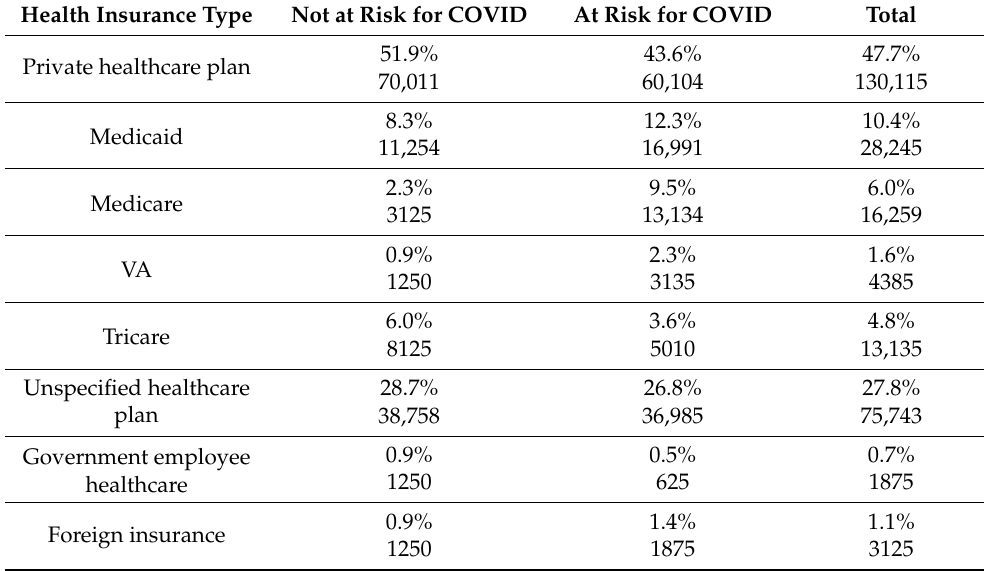
Table 3. Health Insurance Plan and High Risk of COVID-19